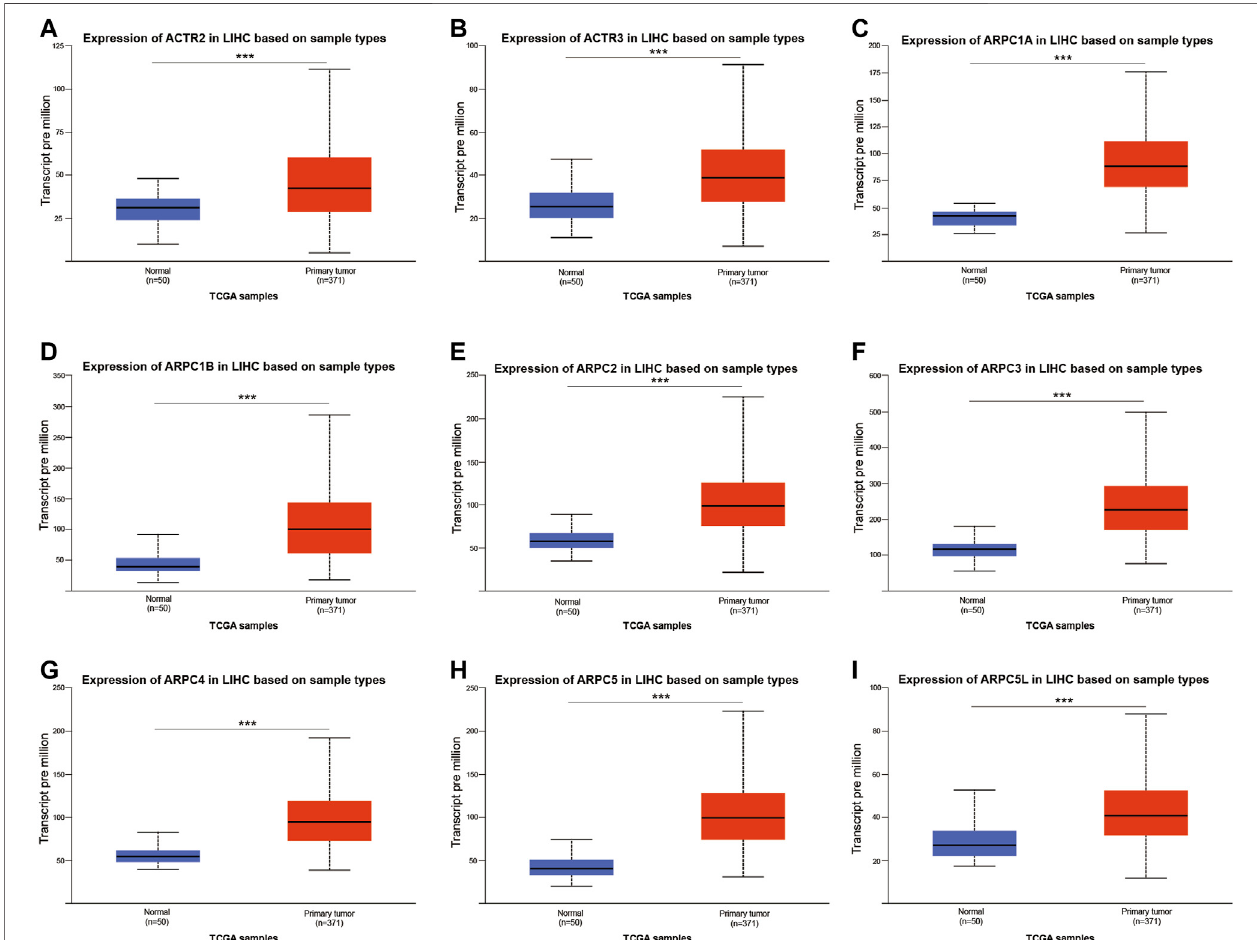
FIGURE 3 | Relative expression of Arp2/3 complex members in normal tissues and HCC tissues based on the UALCAN database (A – I) , *** stands for p < 0.001.